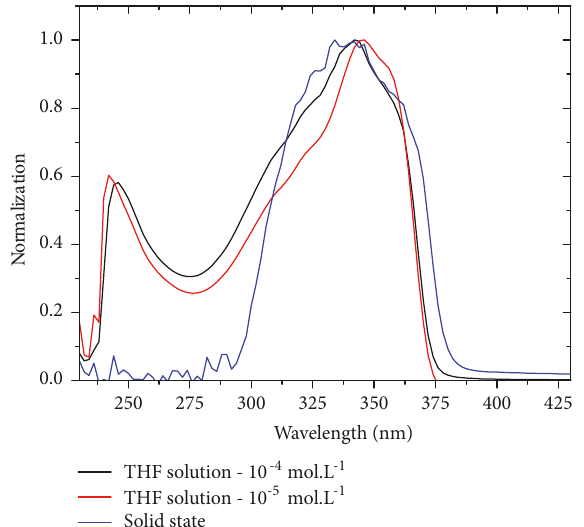
Figure 6: Absorption spectra of LaPPS71 in solution and solid state.